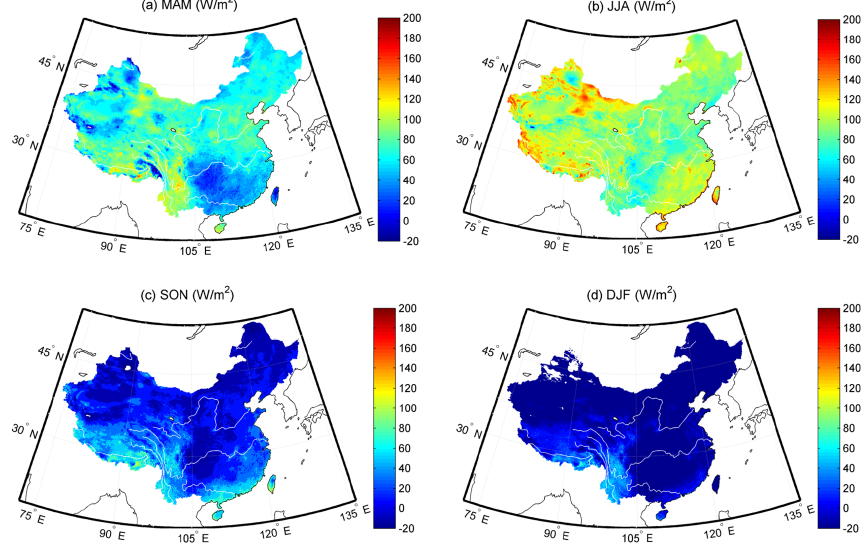
Figure 11. Maps of seasonal average net radiation for (a) March–May (MAM), (b) June–August (JJA), (c) September–November (SON), and (d) December–February (DJF) from 2001 to 2010. White lines show several major rivers in